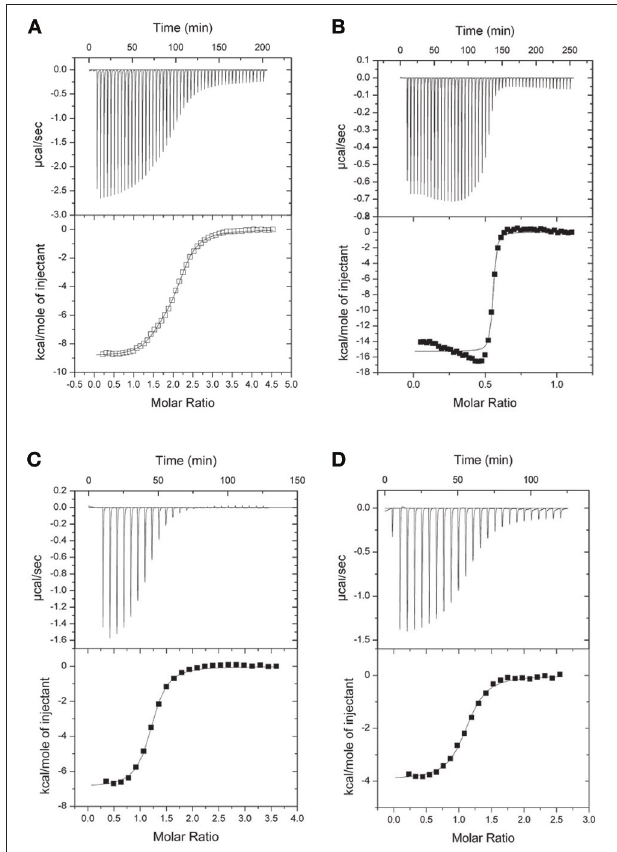
FIGURE 3 | ITC characterization of the interactions of Ca 2 + /CaM with the long NSCaTE peptide. (A) NSCaTE peptide titrated into Ca 2 + /CaM. (B) Ca 2 + /CaM titrated into NSCaTE peptide. (C) NSCaTE peptide titrated into Ca 2 + /CaM-NT. (D) NSCaTE peptide titrated into Ca 2 + /CaM-CT.